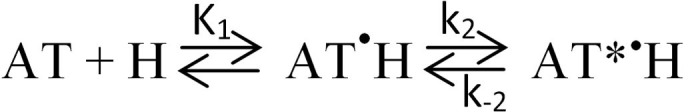
Scheme of binding of antithrombin and heparin.Initial rapid equilibrium, K
1, between antithrombin, AT, and pentasaccharide, H, leads to complex, AT.H, followed by rapid conformational change via k
2 to a high heparin affinity, highly fluorescence complex, AT*.H.